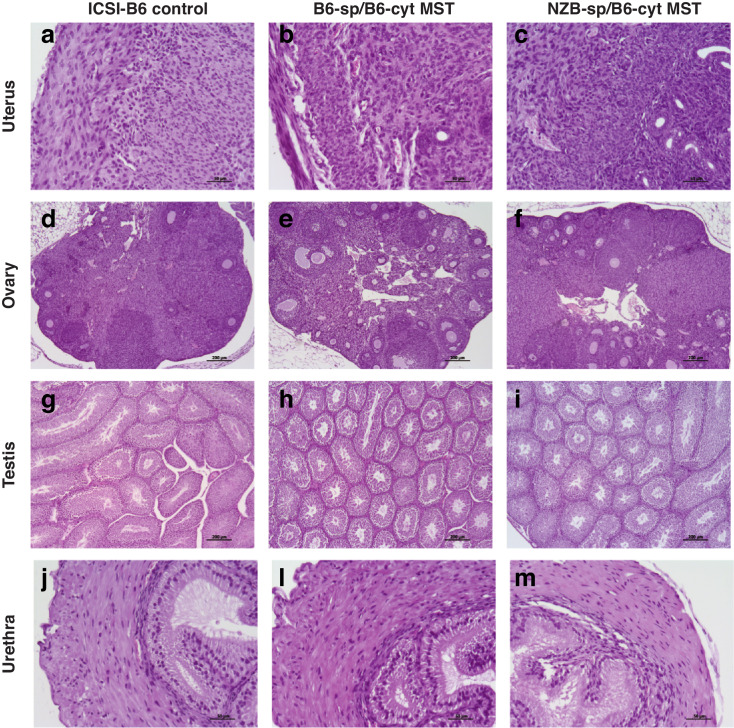
Hematoxylin and eosin (H and E) stained sections of the reproductive organs of adult mice generated from B6 ICSI control embryos, B6 reciprocal MST and NZB-sp/B6-cyt MST embryos.Representative images from uterus (a-c), ovary (d-f), testis (g-i), and male urethra (j-m). All analyzed sections showed the typical morphology of a healthy tissue.